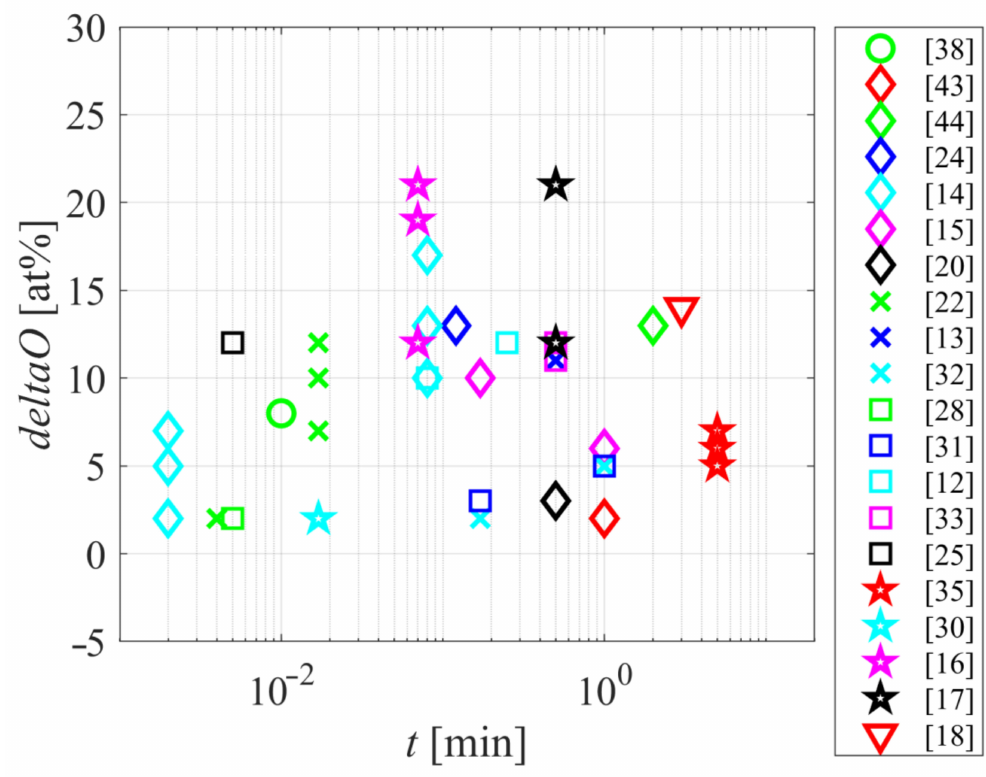
Figure 6. The di ff erence in oxygen concentration as probed by XPS versus the treatment